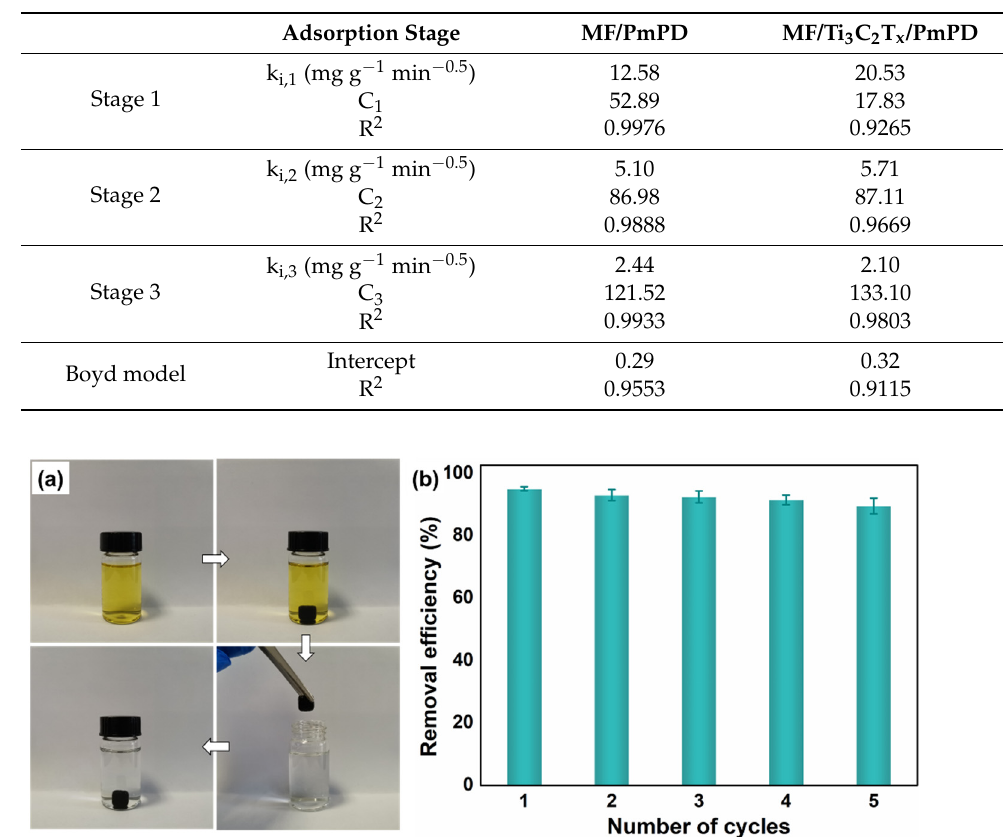
Figure 12. Schematic diagram of adsorption and separation of Cr(VI) by MF/Ti 3 C 2 T x /PmPD ( a ); MF/Ti 3 C 2 T x /PmPD cycle performance ( b ).